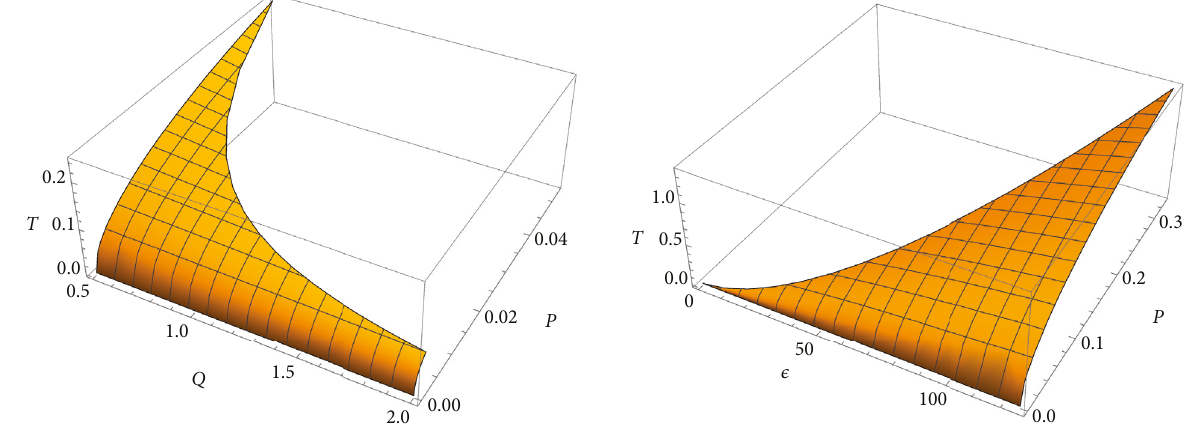
Figure 3: The phase transition coexistence curves for 𝜖 = 8𝜋 (left) and 𝑄 = 1 (right). The end points are the critical points.